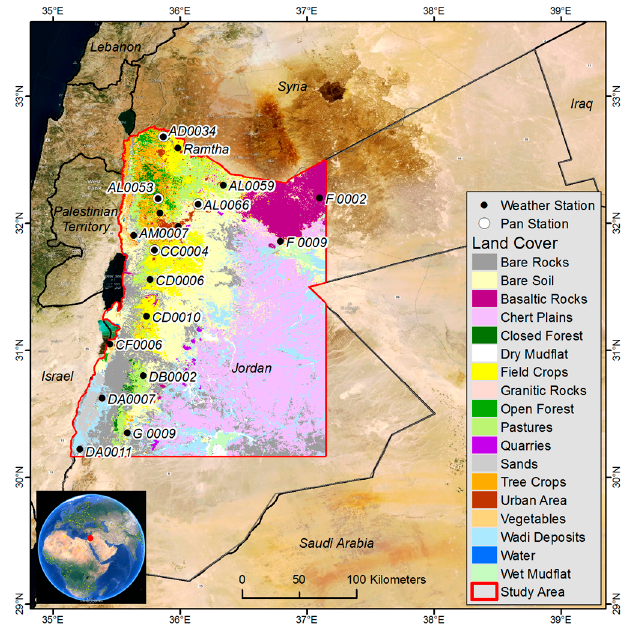
Figure 1. Study area. Black dots indicate the weather stations that are included in the calculation of temperature lapse rate. White circles indicate the selected weather stations with pan evaporation data. The base map is a 2007 land cover map generated from Landsat 7 ETM+ data.